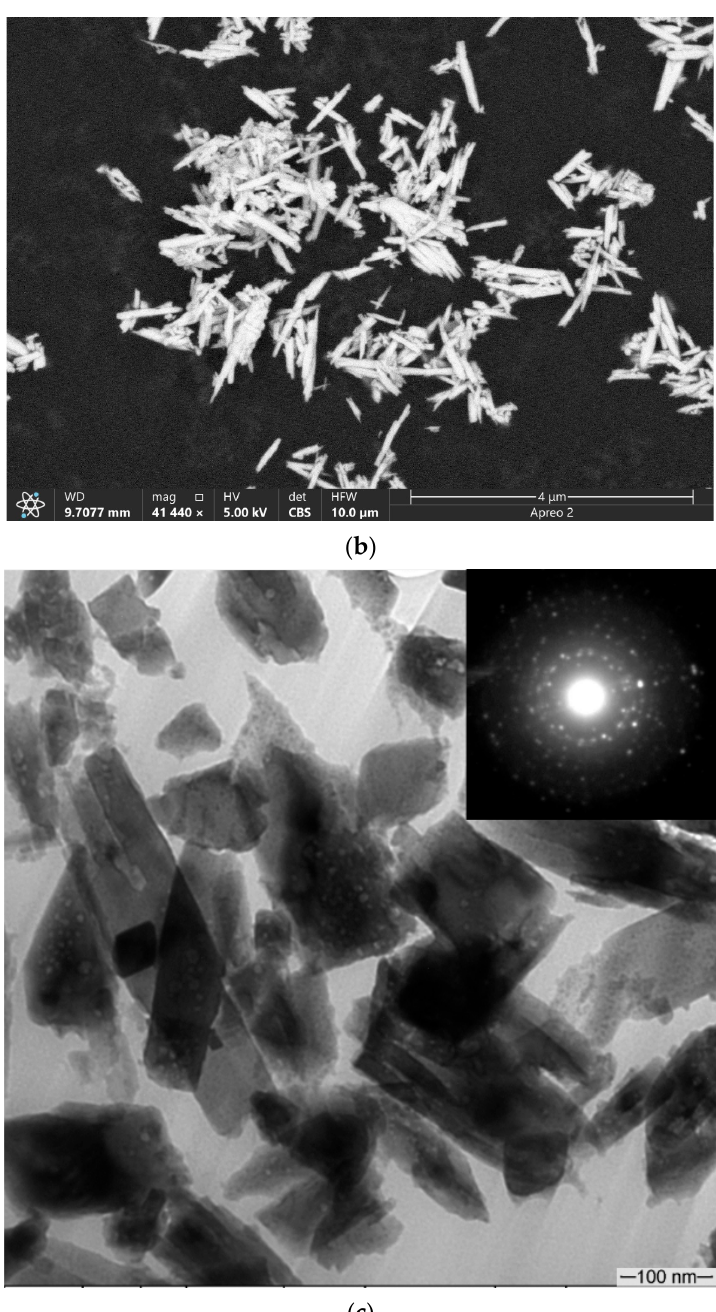
Figure 2. The XRD pattern ( a ), SEM ( b ) and TEM ( c ) images of as-received zirconium tungstate particles.